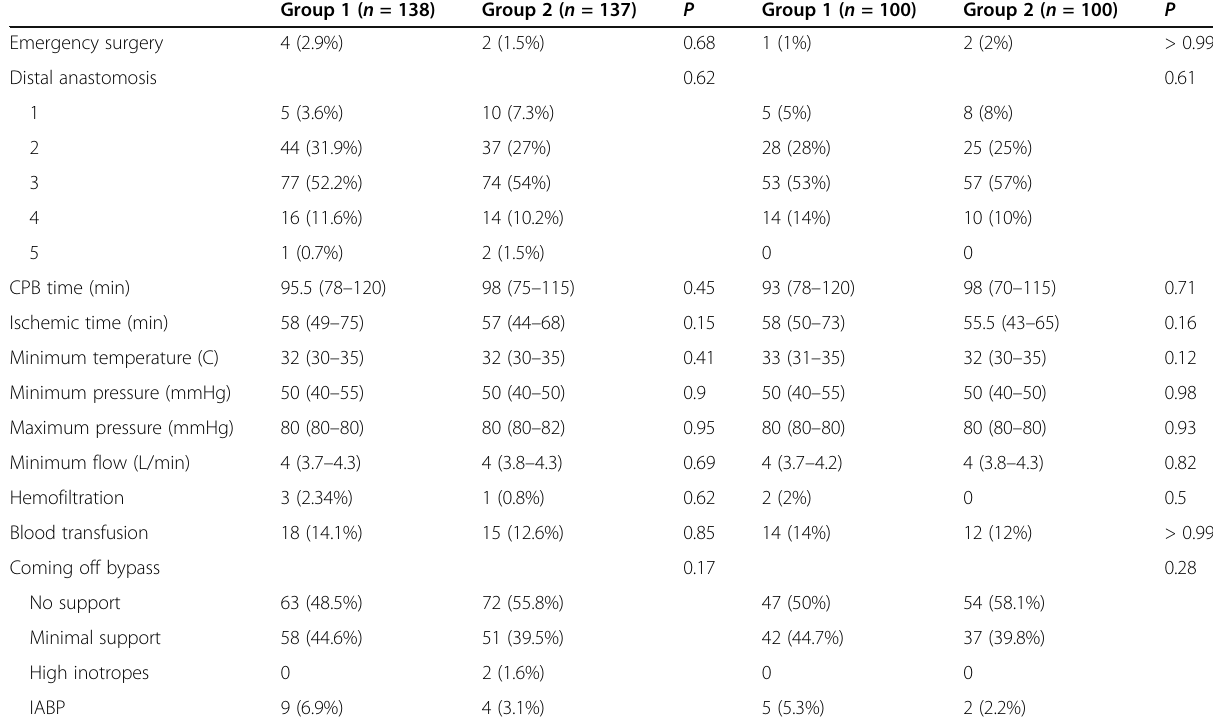
Table 2 Operative data